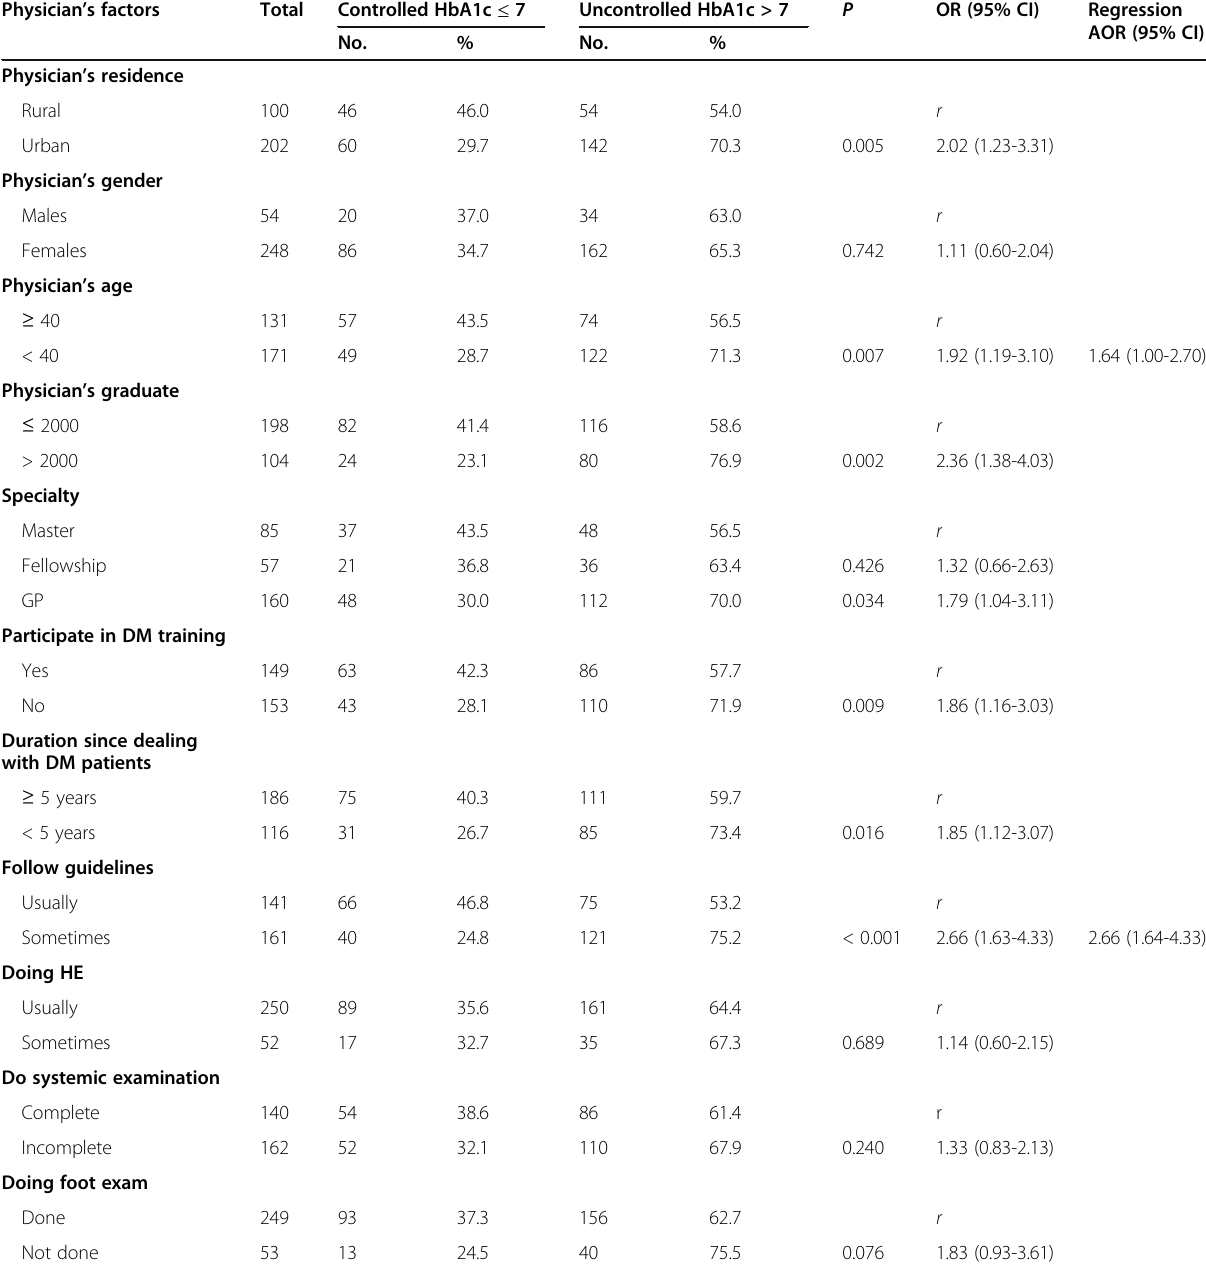
Table 3 Distribution of the studied subjects according blood glucose control and its relation to PCPs factors Physician ’ s factors